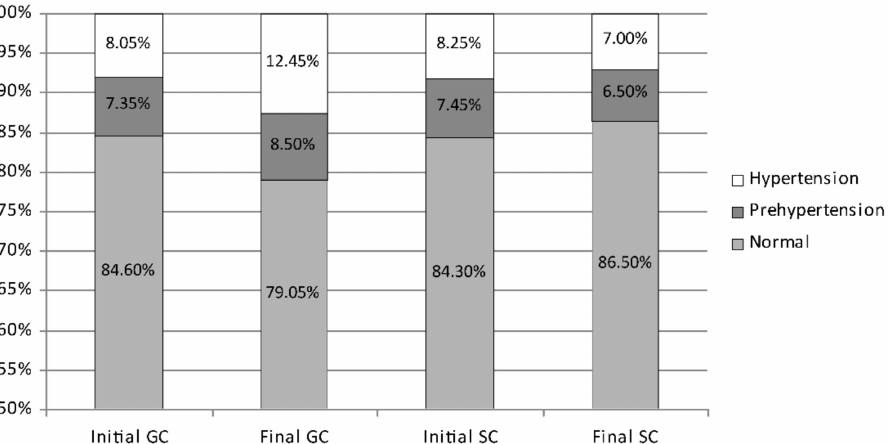
Figure 6. The percentage of boys with diastolic prehypertension, hypertension and normal blood pressure—comparison between the initial and the final measurement sessions. GC—general educa- tion classes (standard PE, 4 h a week); SC—sport classes (elevated PE, 10 h a